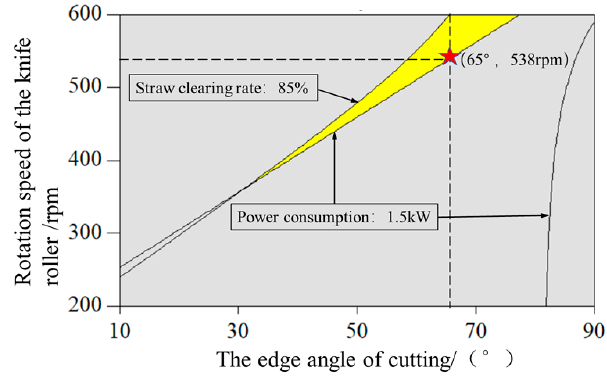
Figure 6. Optimization results of discrete element simulation test.